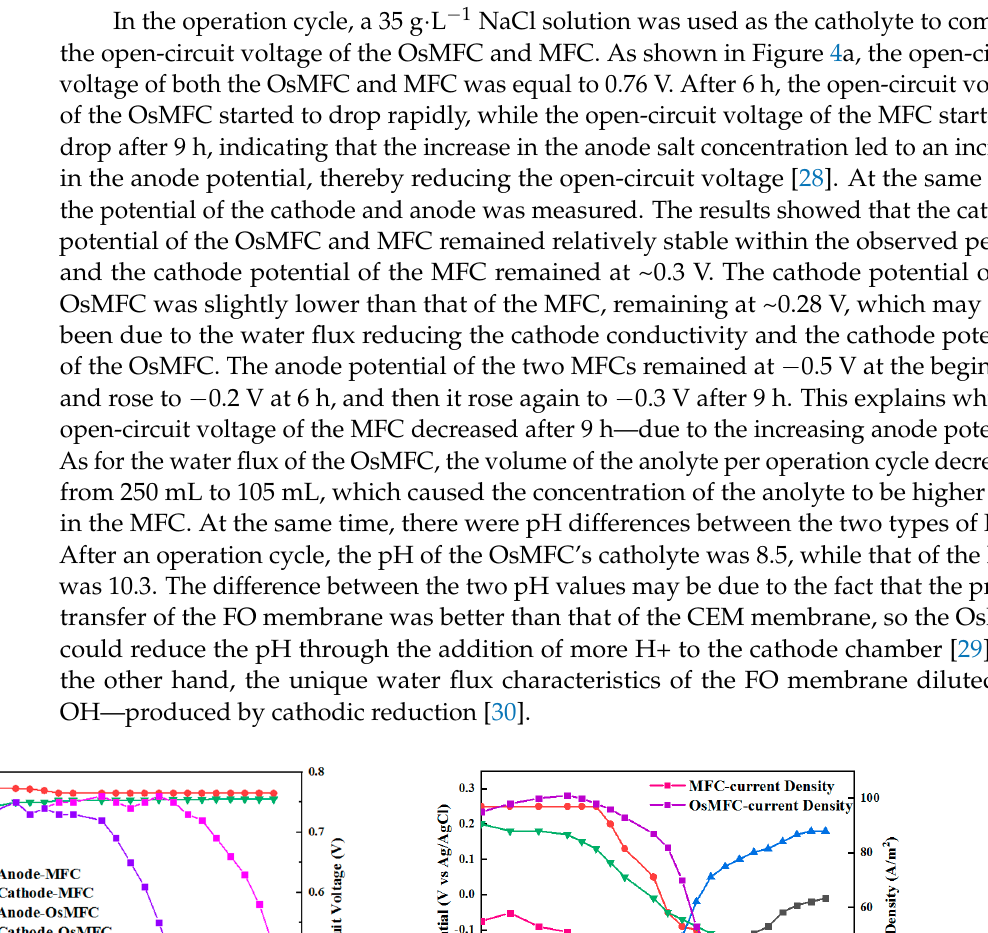
( b ) Figure 5. ( a ) Polarization curves and power density curves of the different partition materials; ( b ) changes in polarization curves after increasing the concentration of the draw solution/catholyte.